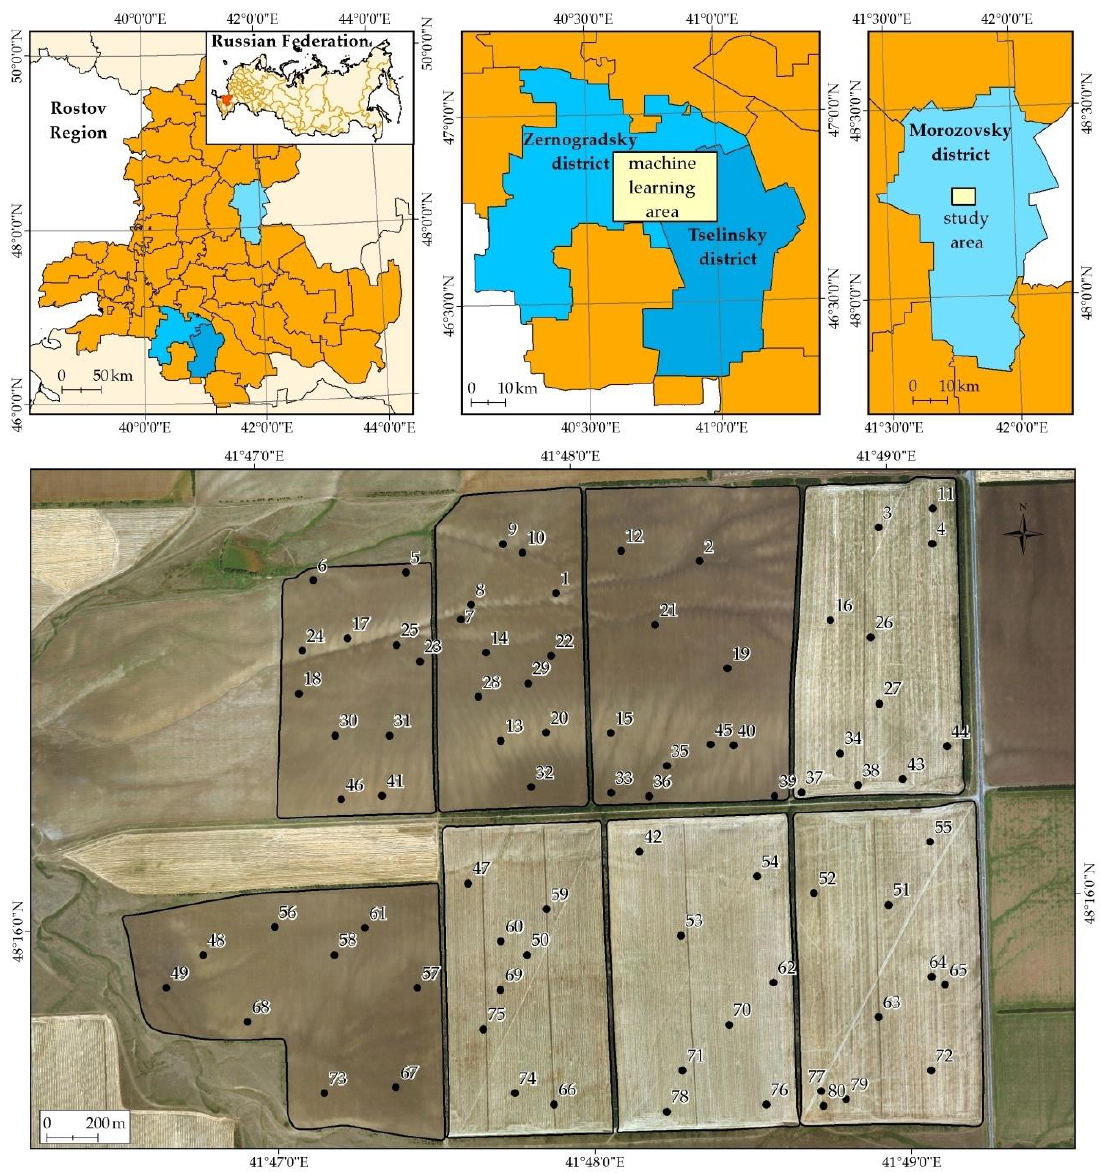
Figure 1. Location of machine learning and study area; fields of acceptance sample and points/numbers of soil pit locations displayed on high resolution RSD.